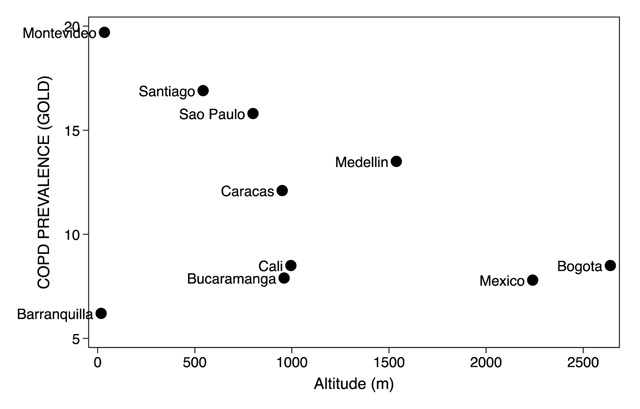
Prevalence of chronic obstructive pulmonary disease in Latin American cities and altitude above sea level. The unlabeled marker in the lower left extreme corresponds to Barranquilla and that in the right axis to Bogota, both in Colombia.